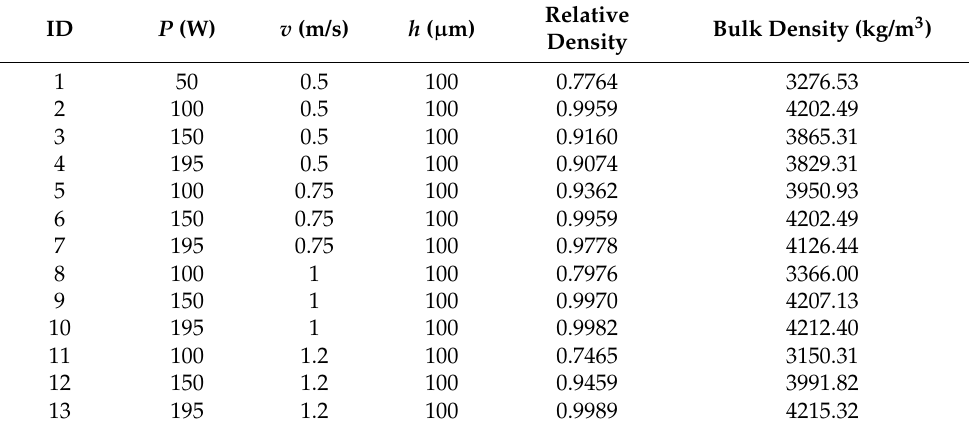
Table A12. Manufacturing parameters and experimental data adapted from [26]. Complementing relevant information and assumptions are the following; material: Ti6Al4V, theoretical density